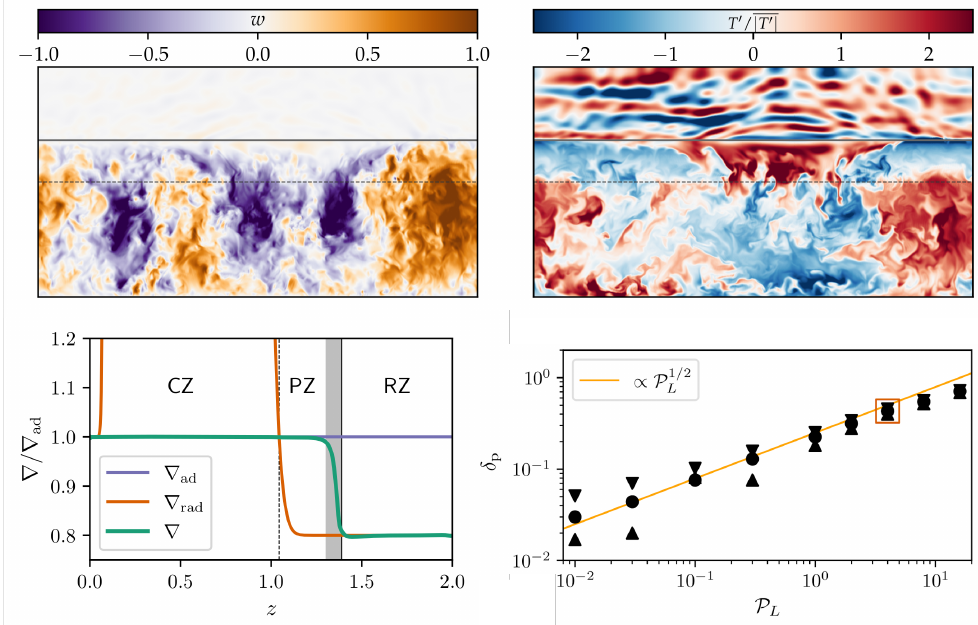
Figure 8. A snapshot in time of a 3D hydrodynamic simulation is displayed in the upper two panels with the velocity (left) and scaled temperature anomaly (right) shown. The Schwarzschild boundary is shown as a dashed line, and height where departs from is plotted as a thick horizontal line. ∇ ∇ ad Note in the upper right panel that hot CZ upwellings turn cold in the penetration zone between the dashed and solid lines. (Bottom left) The time and horizontally averaged profiles from a simulation ∇ such as the one in the top panel; a distinct convection zone (CZ), nearly adiabatic penetration zone (PZ), overshoot zone (gray shaded region) and radiative zone (RZ) are seen. (Bottom right) The extent of the PZ is plotted against the penetration parameter, with the expected scaling overplotted in orange; is found to be the most important parameter for determining the size of the PZ. Figure 1 P (upper two panels), Figure 2 (bottom left panel) and part of Figure 7 (bottom right panel) are